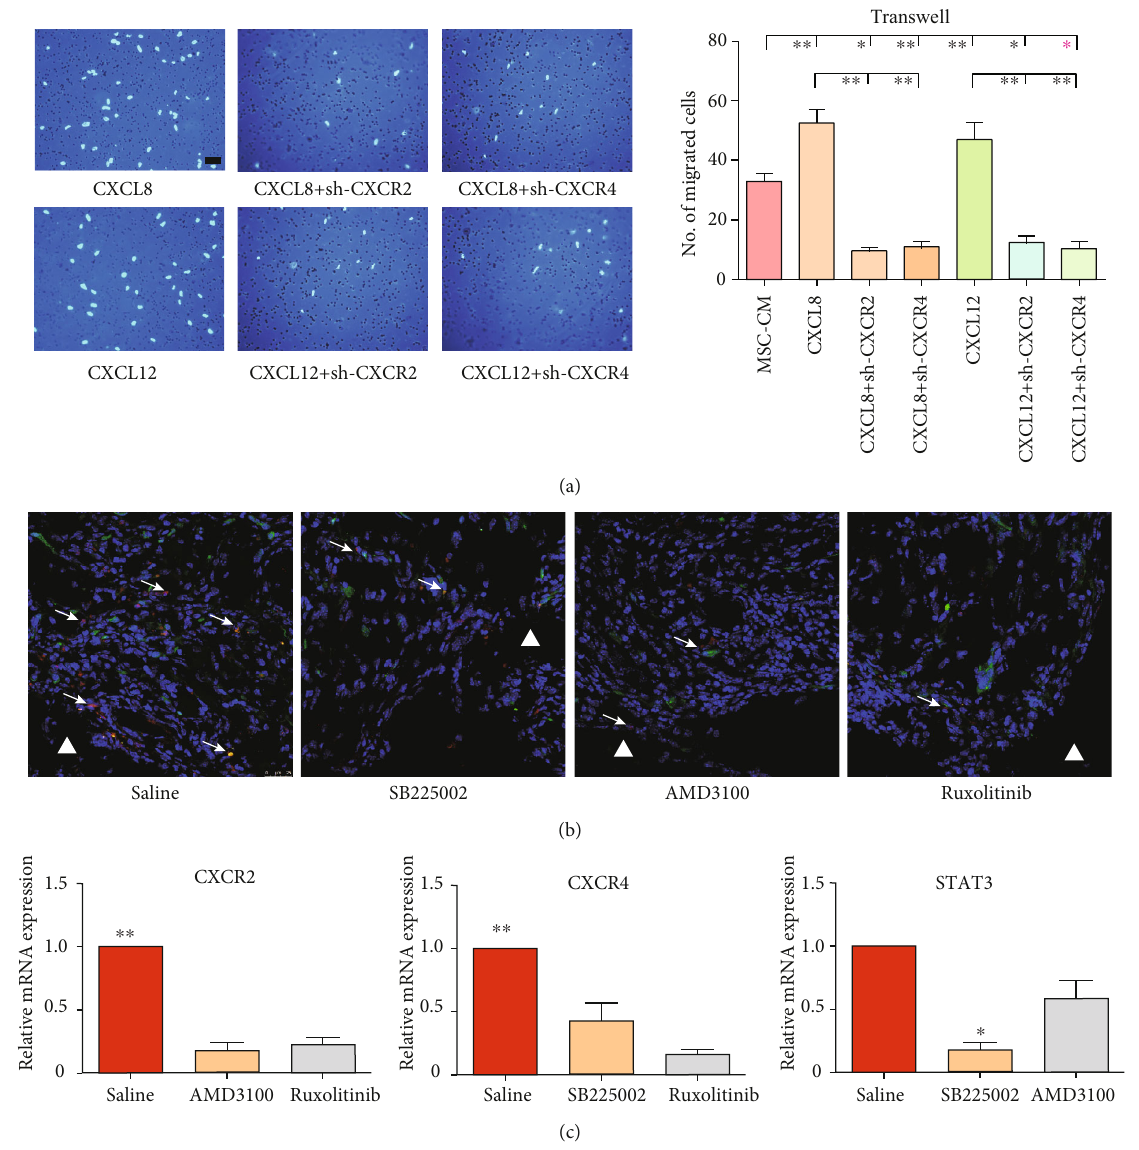
Figure 4: The crosstalk between CXCR2 and CXCR4 contributed to EPC migration. (a) Representative images of migrated EPCs receiving di ff erent treatments. Scale bar, 50 μ m. (b) Representative images of the recruited host CD34 + cells in vivo (white arrows). White triangle: implant area; white arrows: GFP + /CD34 + cells. Scale bar, 25 μ m. (c) Relative mRNA expressions. The quanti fi cation comparison was exhibited as bar graphs ( n = 3 ; ∗ p < 0 : 05 and ∗∗ p < 0 : 01